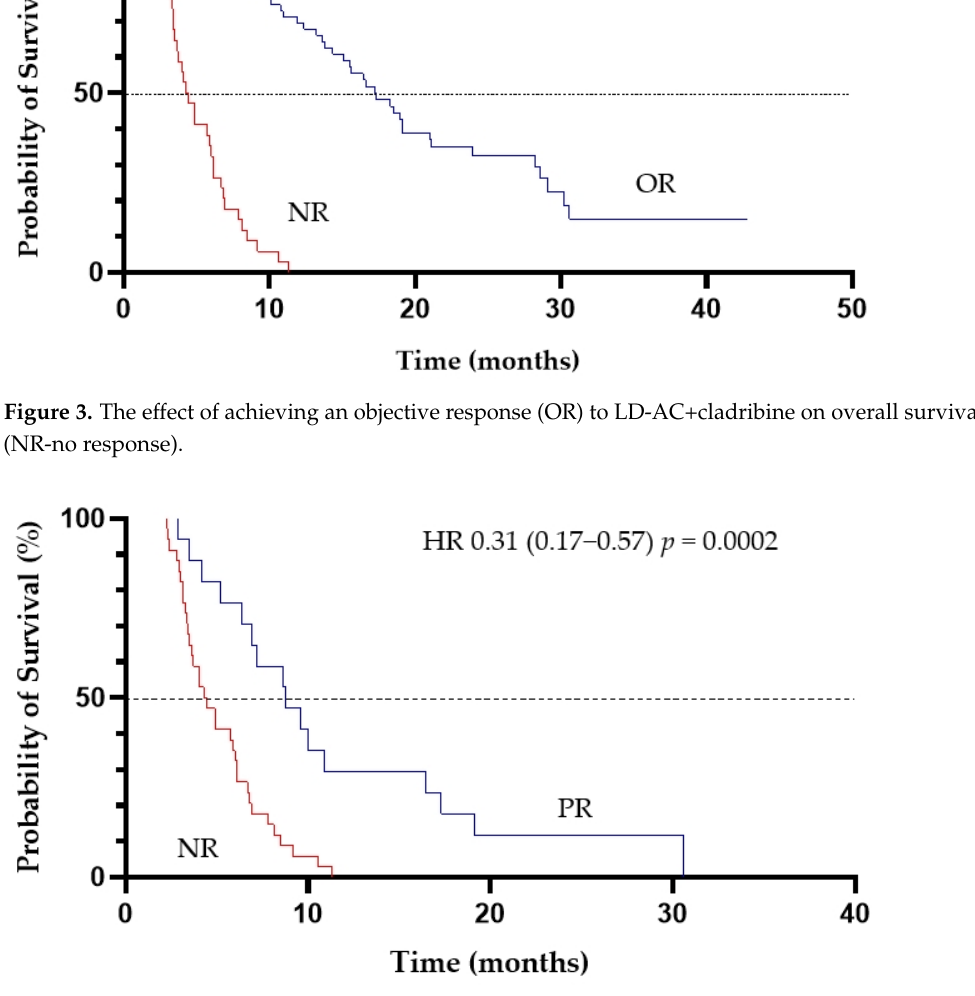
Figure 4. The effect of achieving partial response (PR) to LD-AC+cladribine on overall survival (NR-no response). Table 3. Baseline factors affecting overall survival in univariate and multivariate.